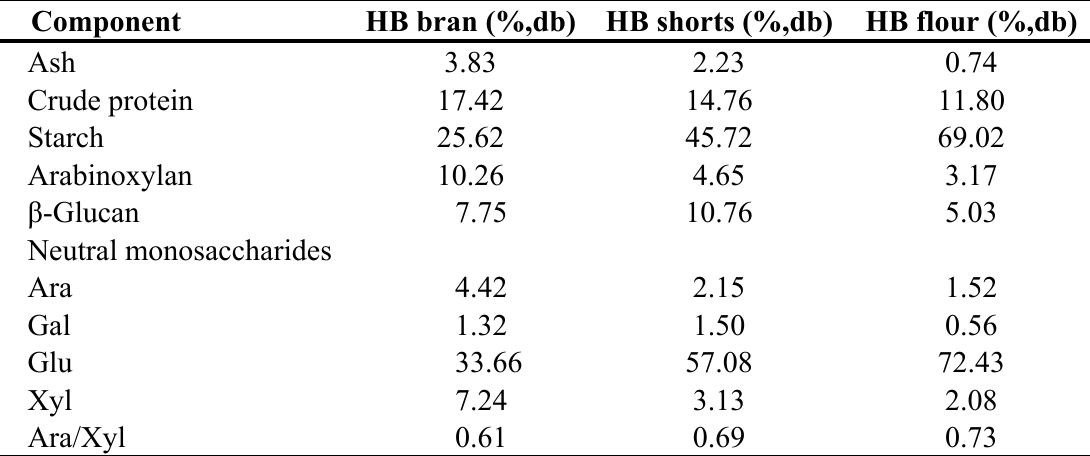
Table 1. Composition of hull-less barley (HB) bran, shorts and flour.